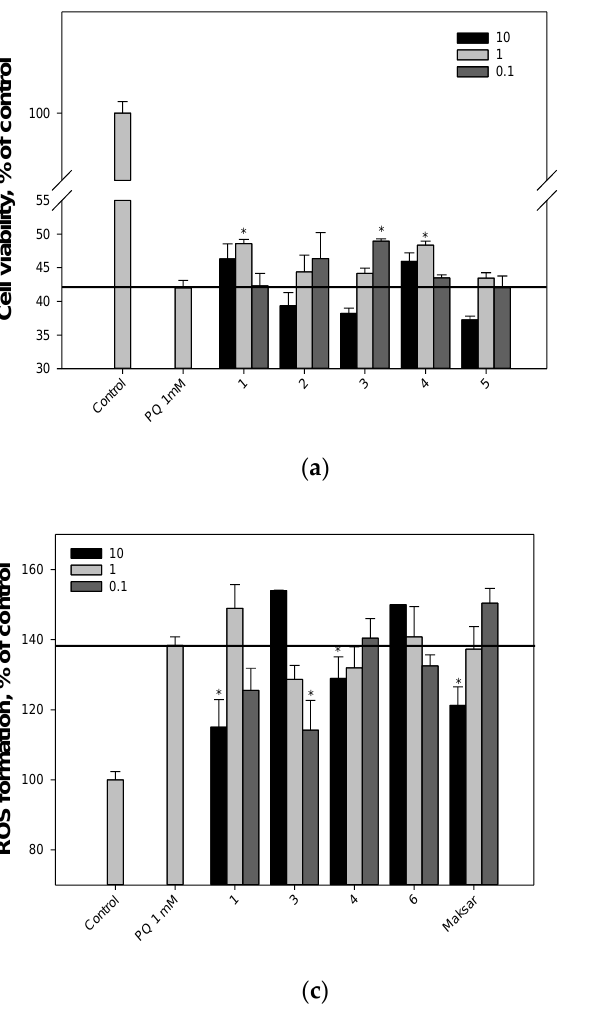
Figure 4. The effect of stilbenes from M. amurensis on cell viability ( a , b ), intracellular ROS levels ( c ), and mitochondrial membrane potential ( d ) in PQ-treated Neuro-2a cells (1 mM). The cell viability after treatment with stilbenes and PQ was measured using the MTT assay. Stilbenes 1 – 6 were used at concentrations 10, 1, 0.1 μM. Maksar ® was used at concentrations 10, 1, 0.1 μg/mL. Data are presented as means ± SEM of three independent replicates. (*) indicated significant difference versus PQ-treated cells ( p < 0.05).